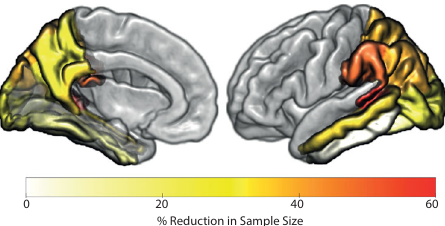
Fig. 5 Reduction in sample size for patient strati fi cation based on prognostic index vs. A β positive. Percentage reduction of sample size required to observe a 25% reduction in tau accumulation per region for Clinically Declining classi fi cation based on multimodal data vs. A β status alone. For example, to observe a 25% reduction in tau accumulation in the middle temporal cortex 34% fewer individuals are required when stratifying based on Clinically Declining classi fi cation vs. A β status alone. In medial and superior-parietal regions (e.g., Precuneus or superior parietal) a sample size reduction of 29% and 39% is achieved when stratifying based on Clinically Declining vs. A β status alone. Source data are provided as